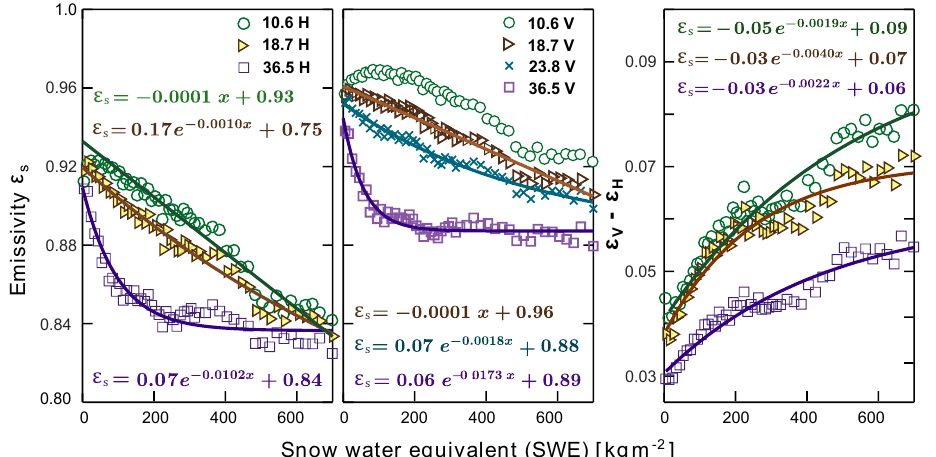
Figure A1. Clear-sky emissivity with snow water equivalent at GPM low-frequency channels (10.6, 18.7, and 36.5 GHz V, H) and the emissivity differences of V-pol and H-pol. Note that the total cloud liquid water path, integrated total precipitable water, and ice water path in the column of the atmosphere, and the near-surface precipitation are all zeros based on the data from both MERRA-2 model simulations and the DPR ancillary database